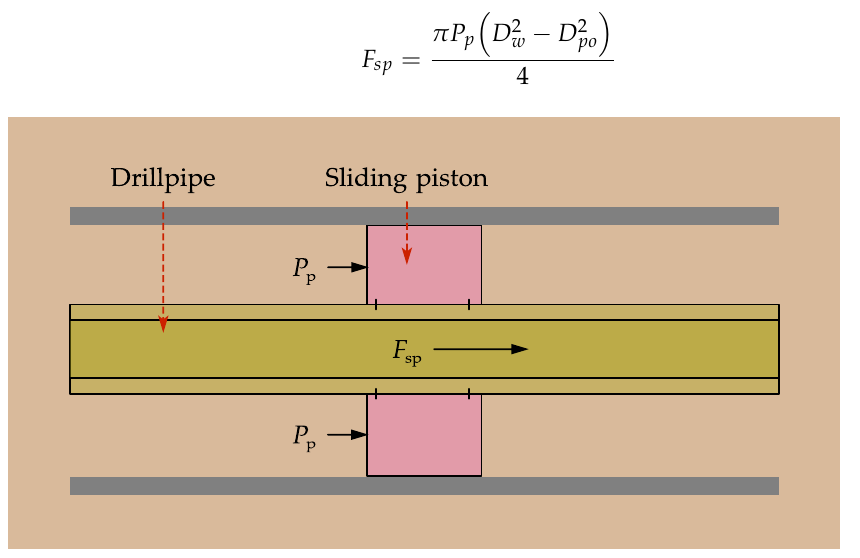
Figure 4. Schematic of a pump-in downhole